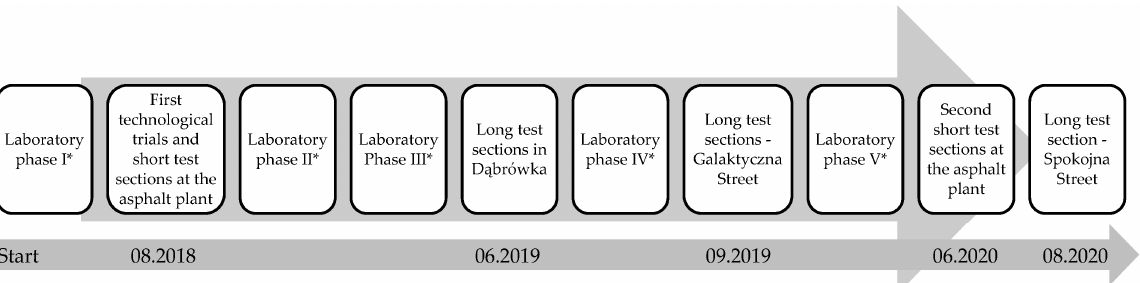
Figure 1. Scheme of the development of the SEPOR poroelastic mix; * detailed description of laboratory phases is provided in Section 3.2.